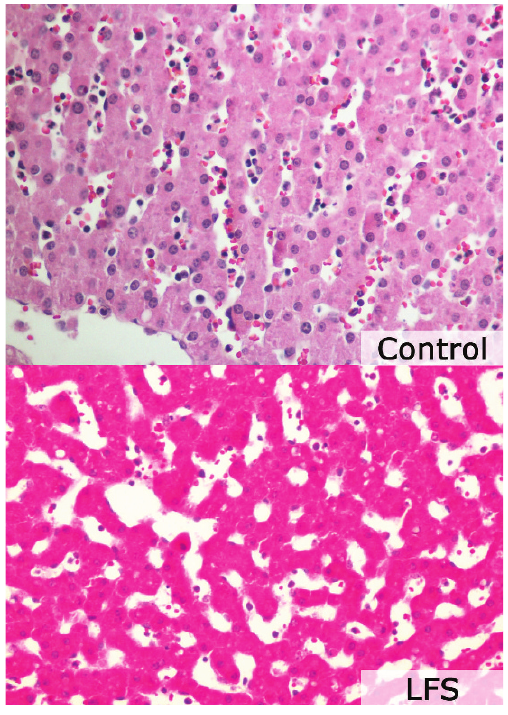
Figure 2 - Histological features of the hepatic parenchyma. Note the similar characteristics of both groups: sinusoidal dilatation and neutrophil